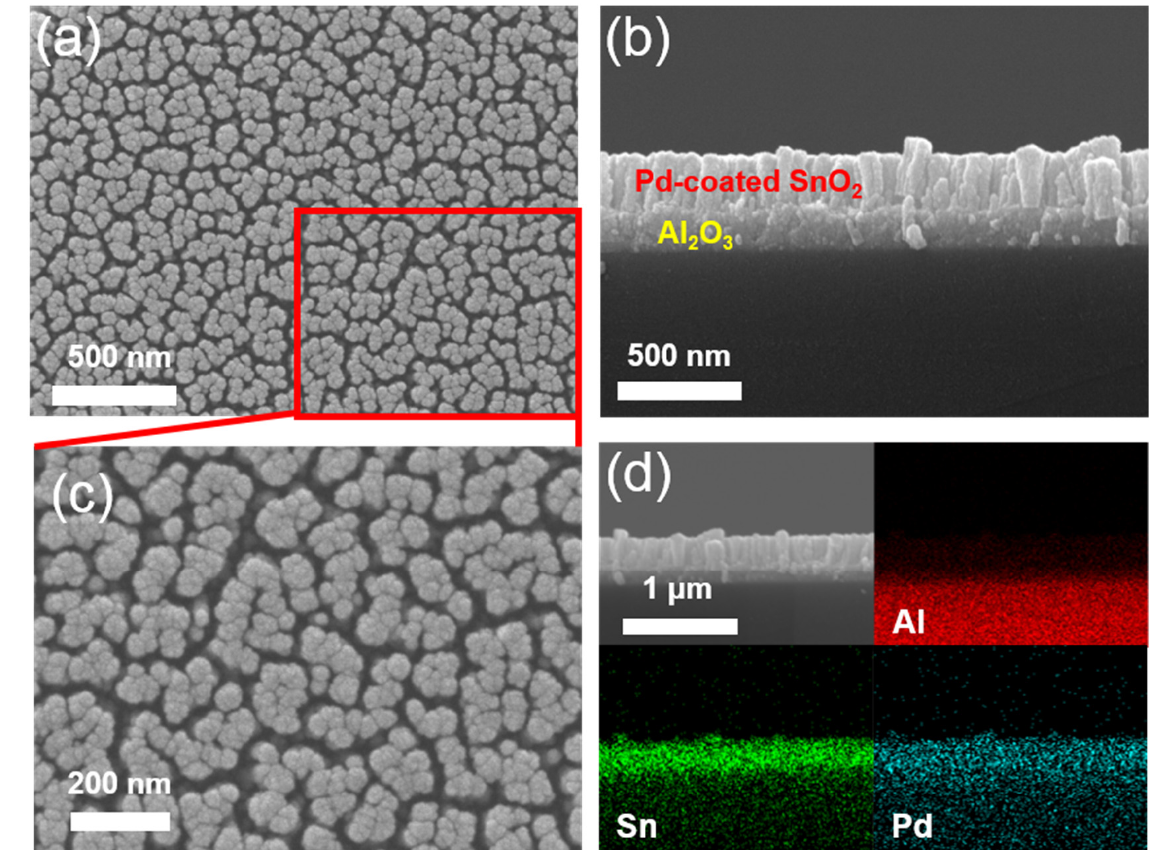
Figure 3. ( a ) Top-view SEM images of the Pd-coated SnO 2 NR arrays; ( b ) cross-view SEM images of the Pd-coated SnO 2 NR arrays; ( c ) a magnified view of ( a ); ( d ) SEM image depicting the analyzed region and the EDS elemental color mapping images for Al, Sn, and Pd.